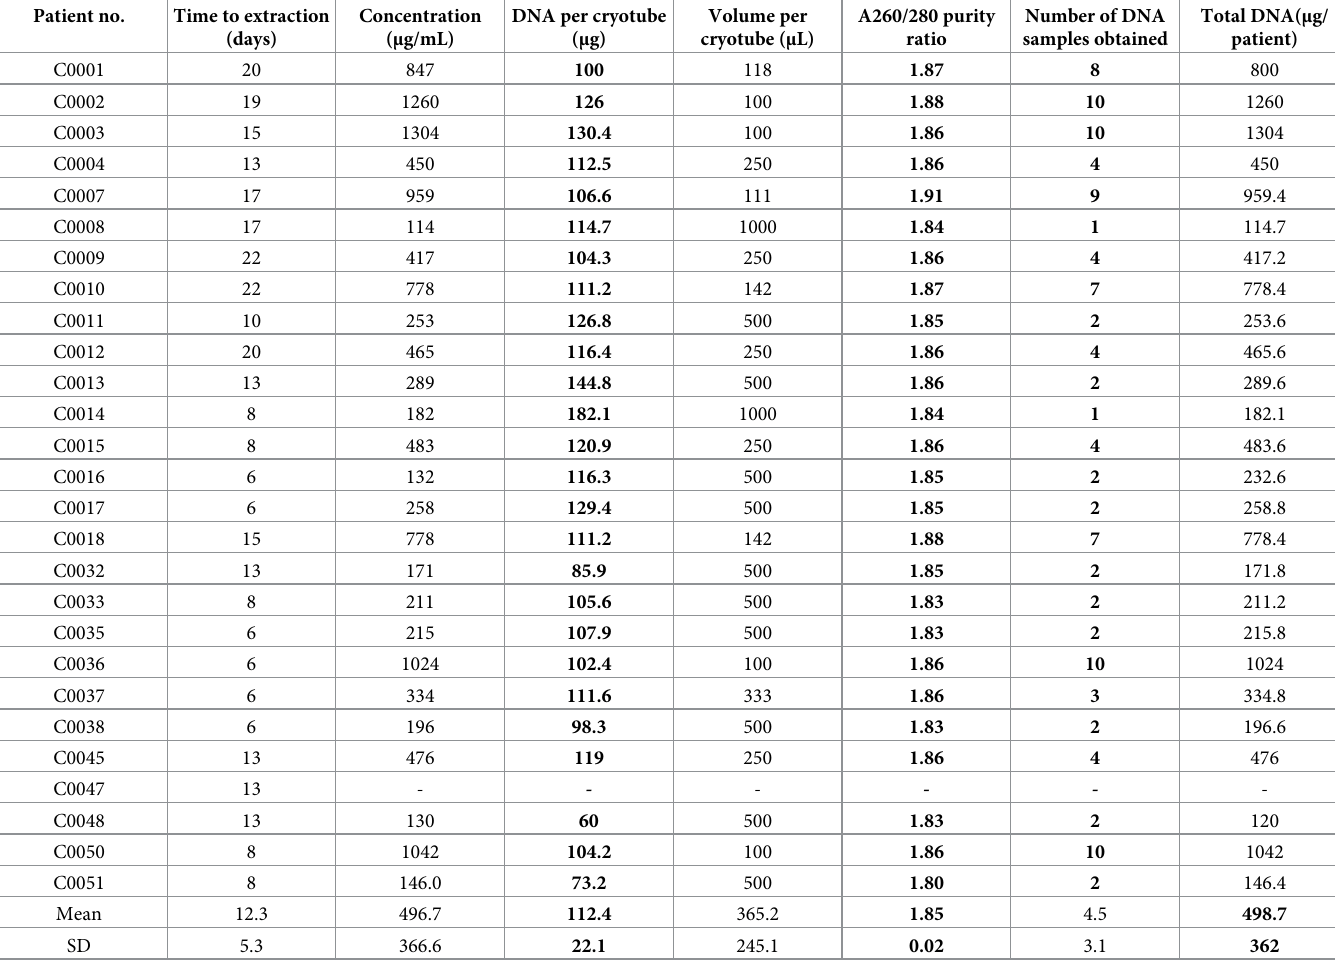
Table 4. Quality metrics of DNA isolated from blood. The concentration and purity of the DNA samples isolated from the patients’ blood were evaluated based on spec- trophotometric measurements at 260 nm and 280 nm. Patient